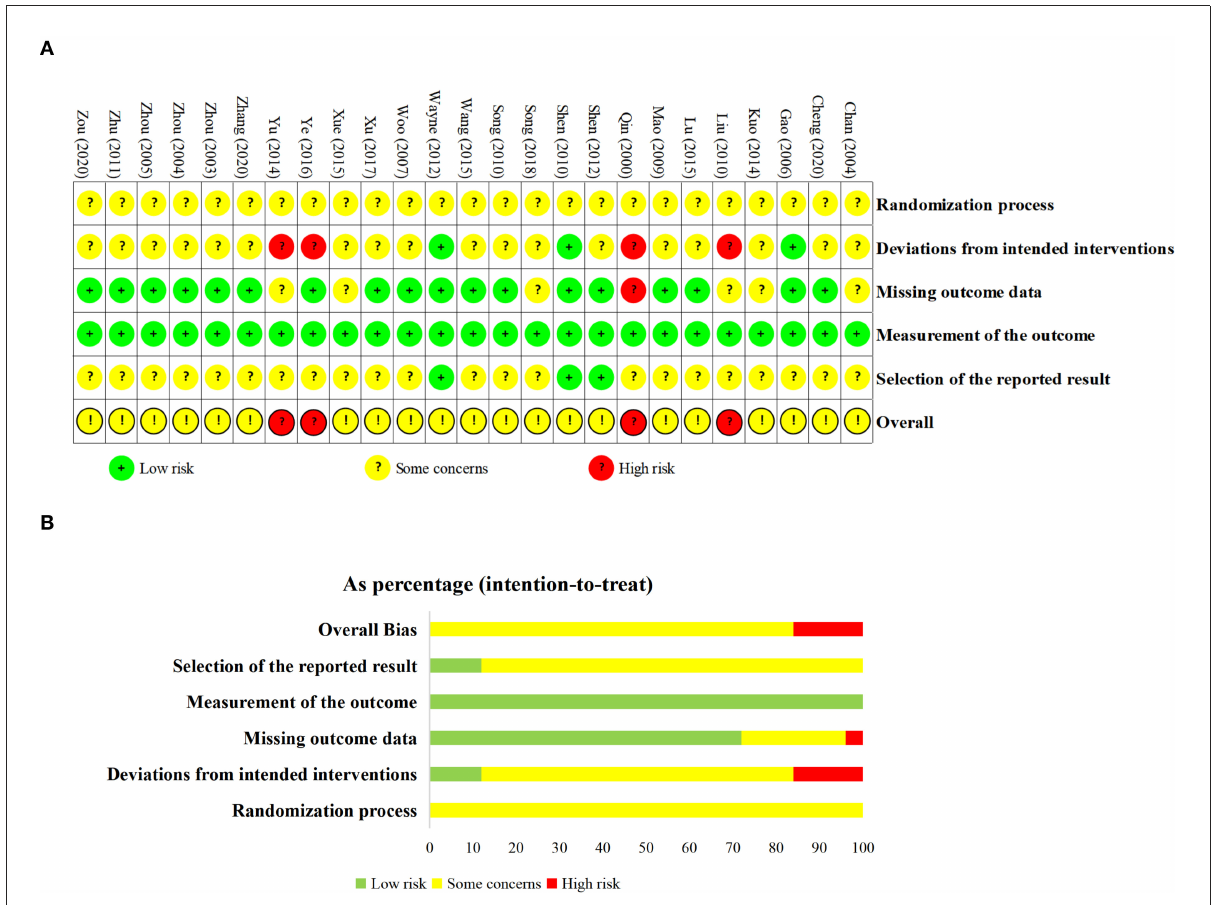
FIGURE2 Results of risk of bias assessment. (A) the domain and overall judgments study-by-study; (B) proportions of studies at low risk, some concerns or high risk of bias for each